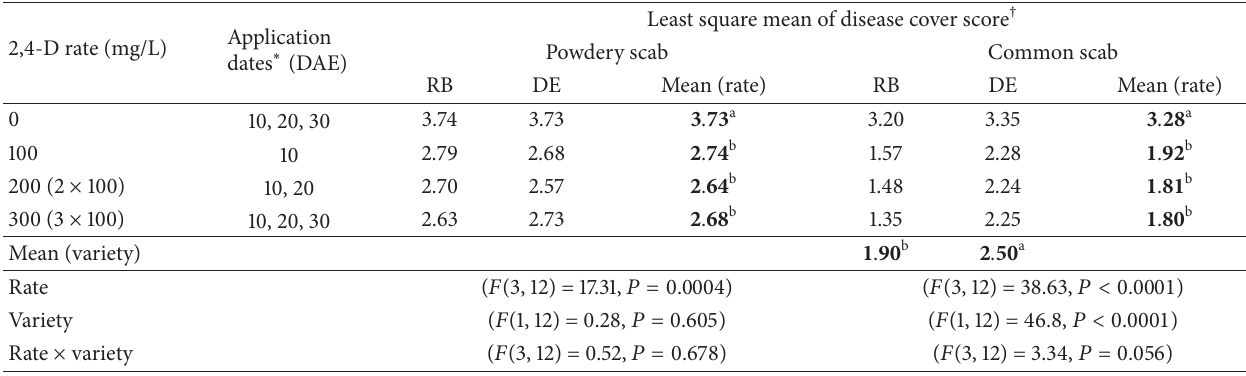
Table 2: Field trial number 1: effect of single or multiple foliar applications of 100 mg/L 2,4-D on plants of potato varieties Russet Burbank (RB) and Desiree (DE) on powdery scab and common scab severity.